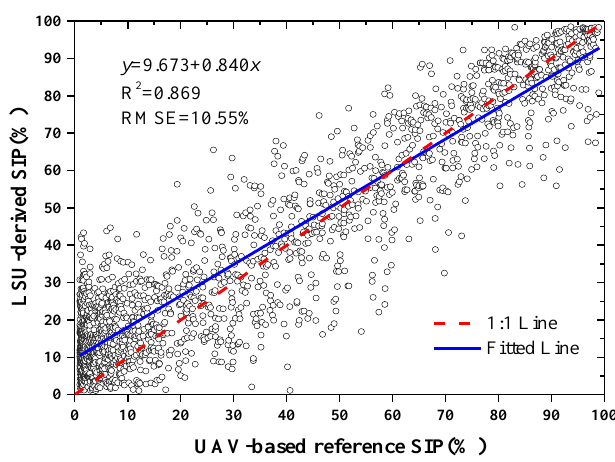
Figure 8. The R 2 and root mean squared error (RMSE) of the relationships between the UAV-based reference and Landsat-predicted SIP using LSU method in 2014. The red dotted lines are the 1:1 lines, and the blue solid lines are linear regressions between the predicted and UAV-based reference SIP.